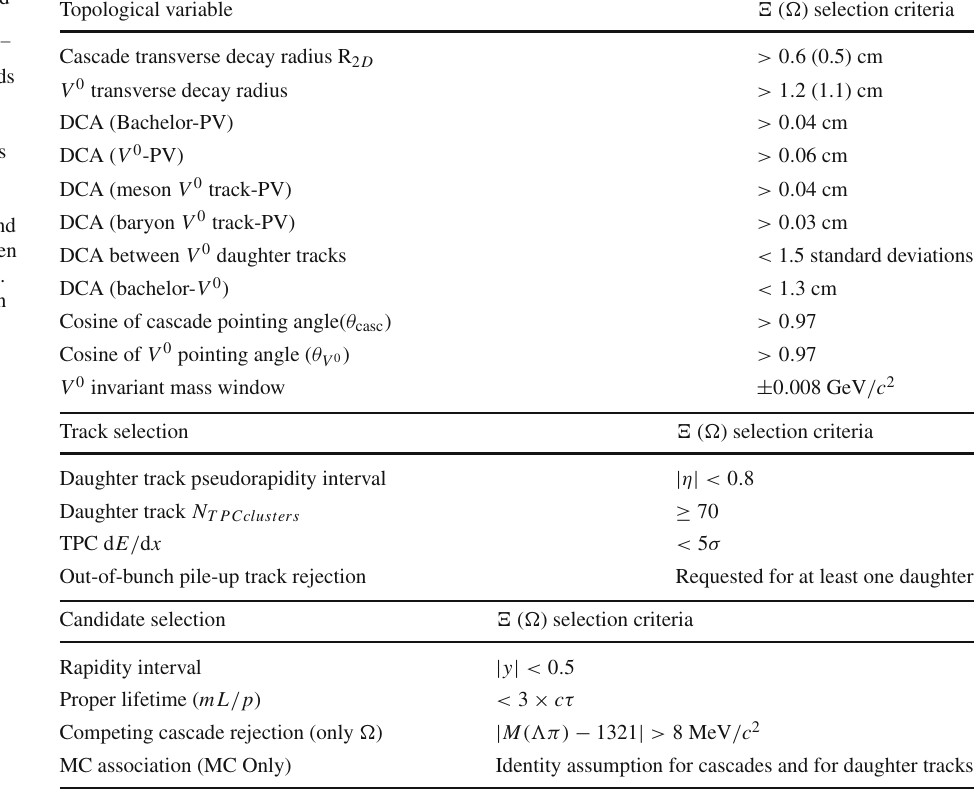
Table 3 Track, topological and candidate selection criteria + applied to charged (cid:4) − , (cid:4) , (cid:5) − + and (cid:5) candidates. DCA stands for “distance of closest approach”, PV represents